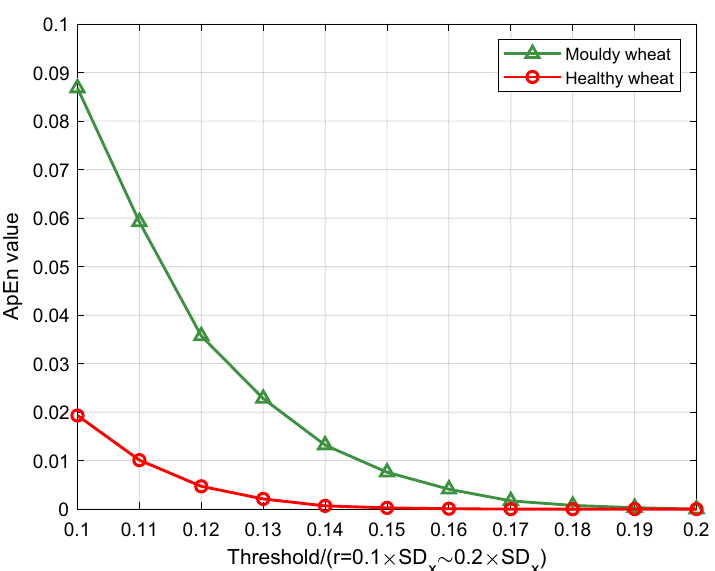
Figure 6. ApEn values of UWL signals of the healthy and the moldy wheat with different tolerance